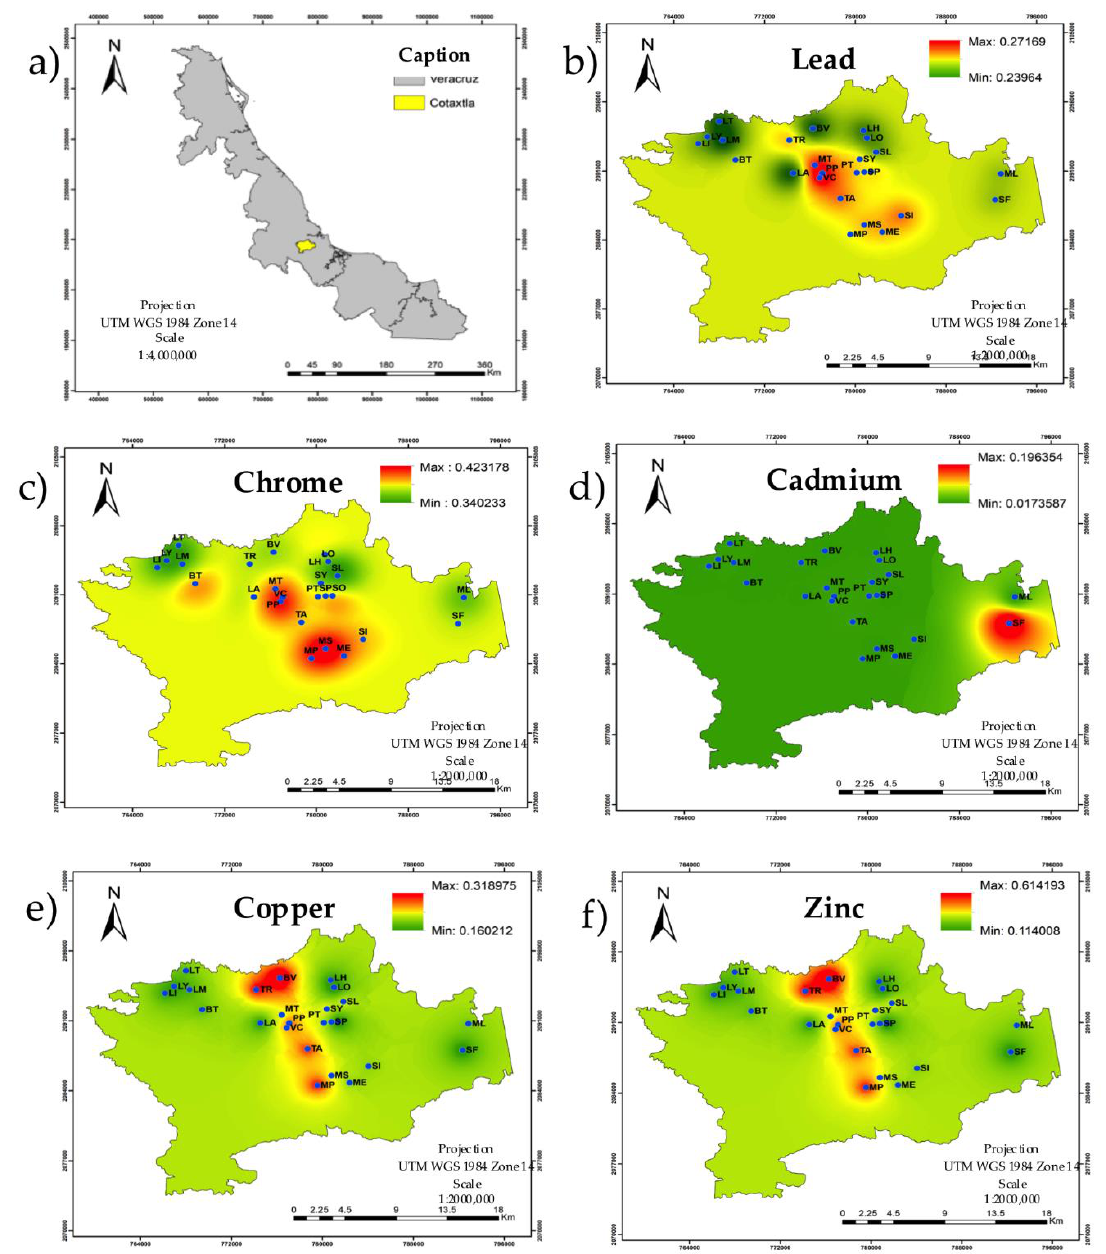
Figure 2. Special distribution of heavy metals from the study area of the Sotavento region in the central area of the Gulf of Mexico; ( a ) Cotaxtla, Veracruz, México, ( b ) lead, ( c ) chromium, ( d ) cadmium, ( e ) zinc, ( f ) chromium. Note: BT, Bajos Tlachiconal; LI, Lomitas3; TA, Los Tamarindos; MT, Mata Tambor; SO, Soyolapa1; BV, Buena Vista; LT, Lomitas4; ME, Mata Espino1; PT, Potrerillo1; SY Soyolapa2; TR,